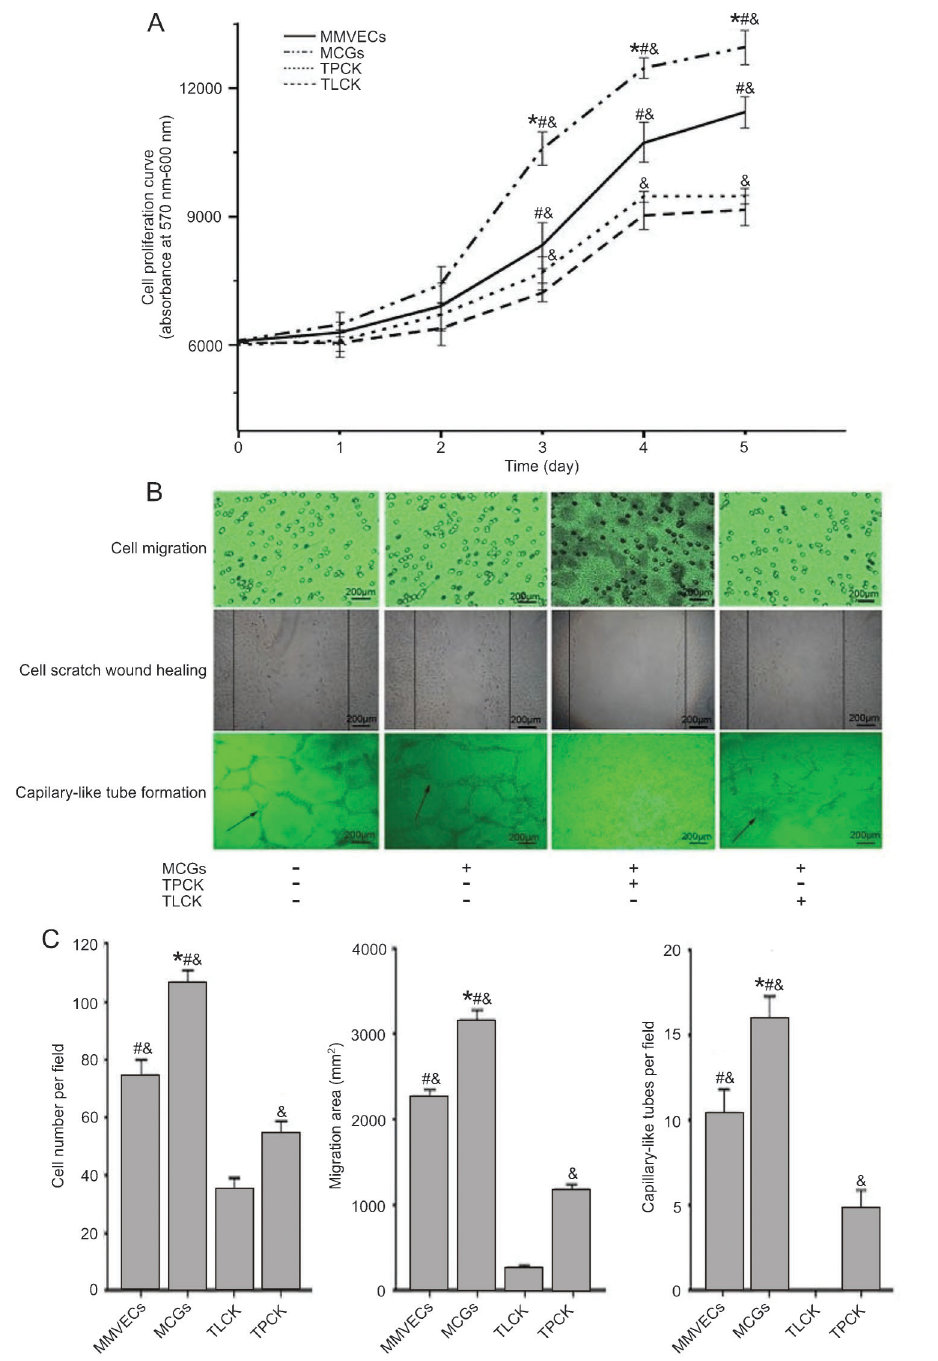
Figure 2. Angiogenesis changes in different conditions in vitro . A , Cell proliferation curve was obtained by AlamarBlue 1 cell viability reagent. B , C , Representative images of migration across Transwell membrane, scratch wound healing and capillary-like tube formation were captured and counted under a contrast phase microscope. Data are reported as means±SE (n=3). MMVECs: myocardial microvascular endothelial cells; MCGs: mast cell granules; TLCK: N -tosyl-L-lysine chloromethyl ketone; TPCK: N -tosyl-L-phenylalanyl chloromethyl ketone. *P , 0.05 vs MMVECs, & P , 0.05 vs TLCK, # P , 0.05 vs TPCK (Student-Newman-Keuls